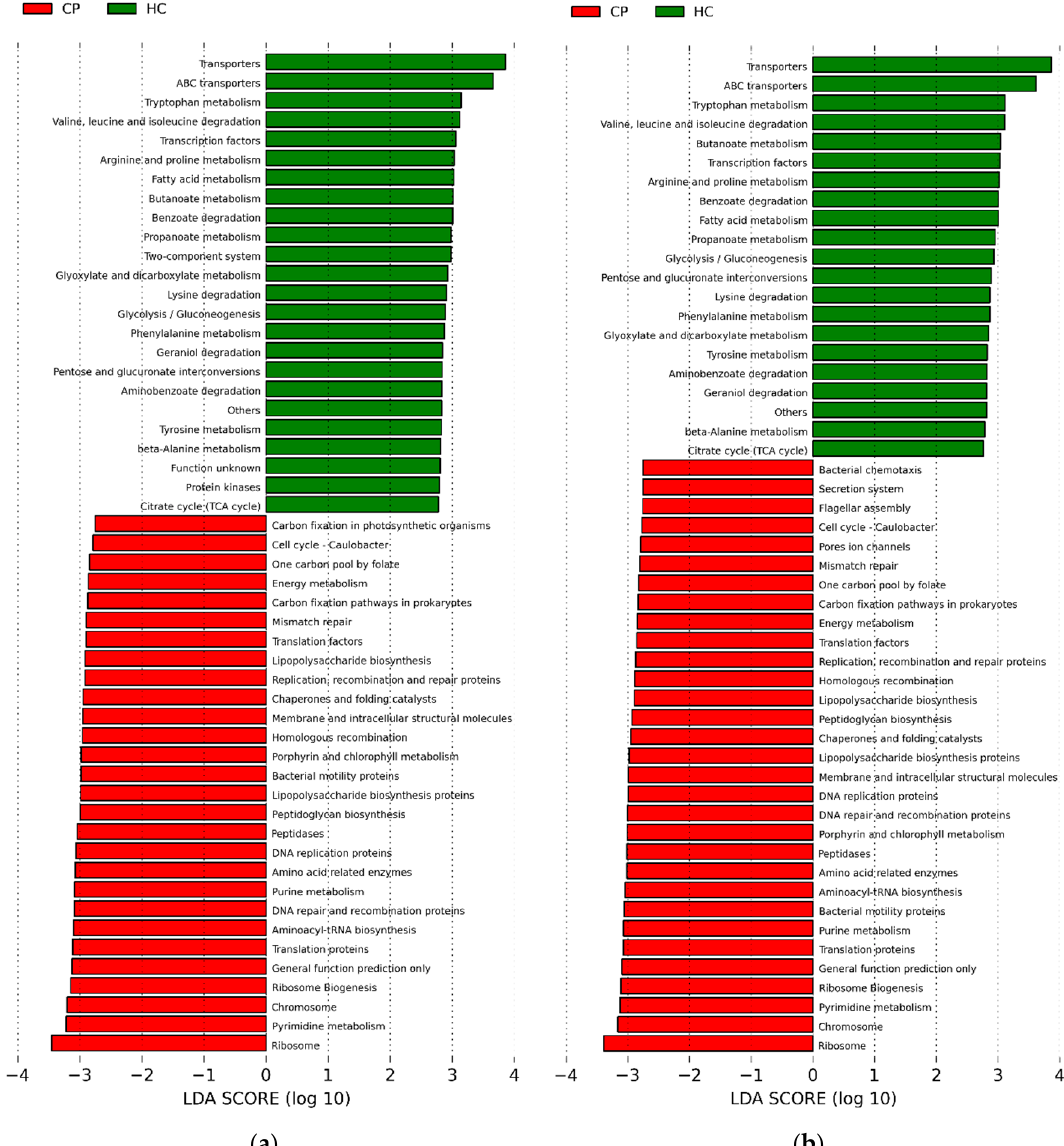
Figure 6. Functional pathways attributed to subgingival biofilm communities. Green bars (HC) are for women with healthy periodontium, Red bars (CP) for women with periodontal disease. ( a ) Panel A. Functional attributes for samples taken from the upper arch; ( b ) Panel B. Functional attributes for samples taken from the lower arch.